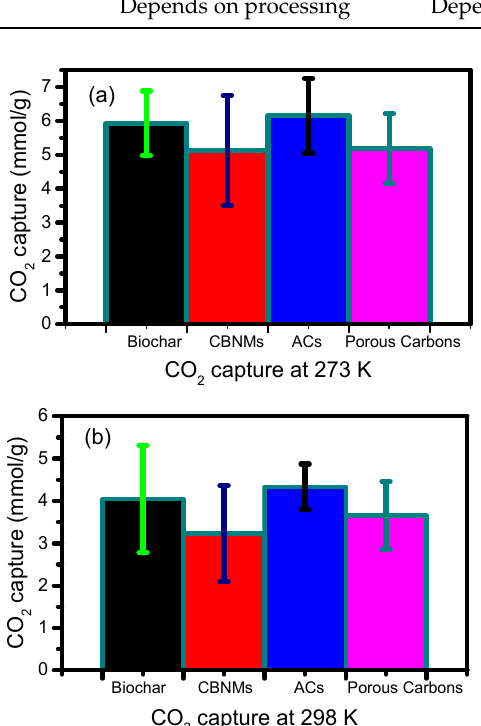
Figure 4. Average (with standard deviation) CO 2 capture performance by di ff erent carbon-based materials at two di ff erent temperatures, i.e., 273 K and 298 K, respectively. Biochar refers to biochar and activated biochar; CBNMs refers to graphene, graphene oxide, CNTs, and their composites; porous carbon refers to micro, meso, and hierarchical porous carbons. Each set of data refers to the average value (with standard deviation) at the adsorption capacities of each type of material, which was generated from Tables 1–4.